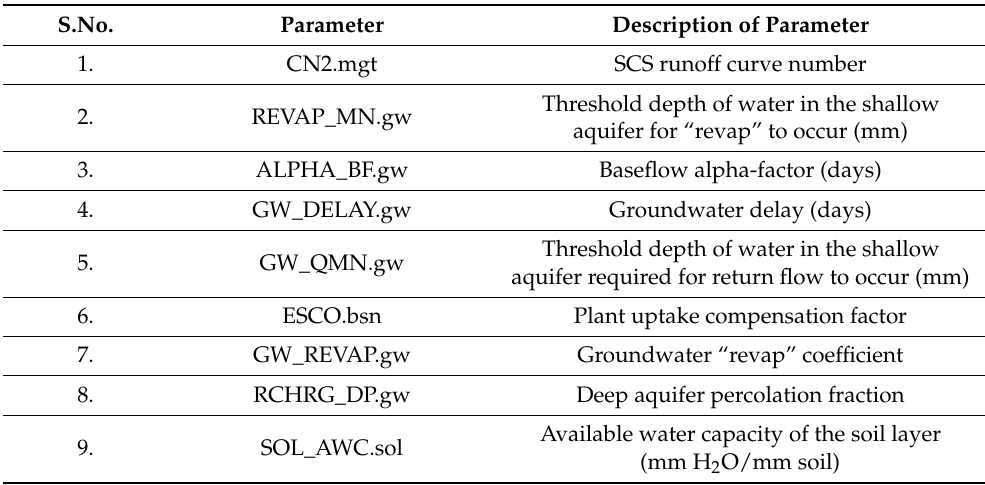
Table 4. Sensitive parameters obtained for the Peachtree region Creek Watershed from the global sensitivity